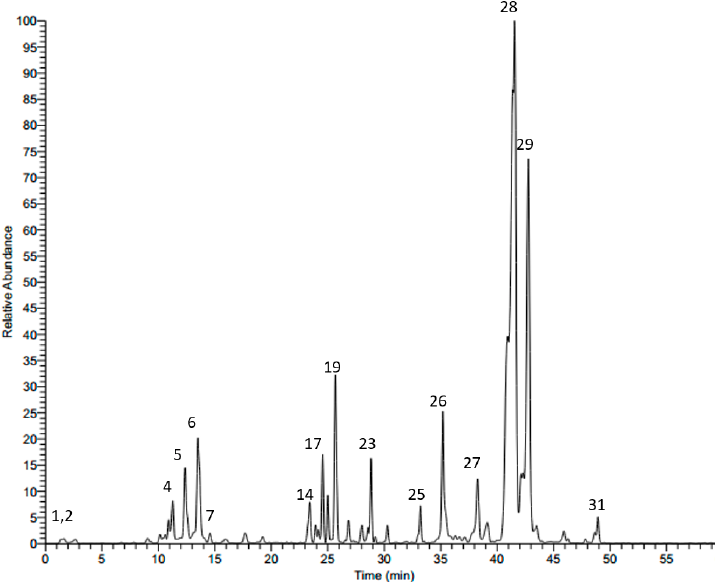
Figure 1. LC-MS profile of the methanol extract from S. atropurpurea